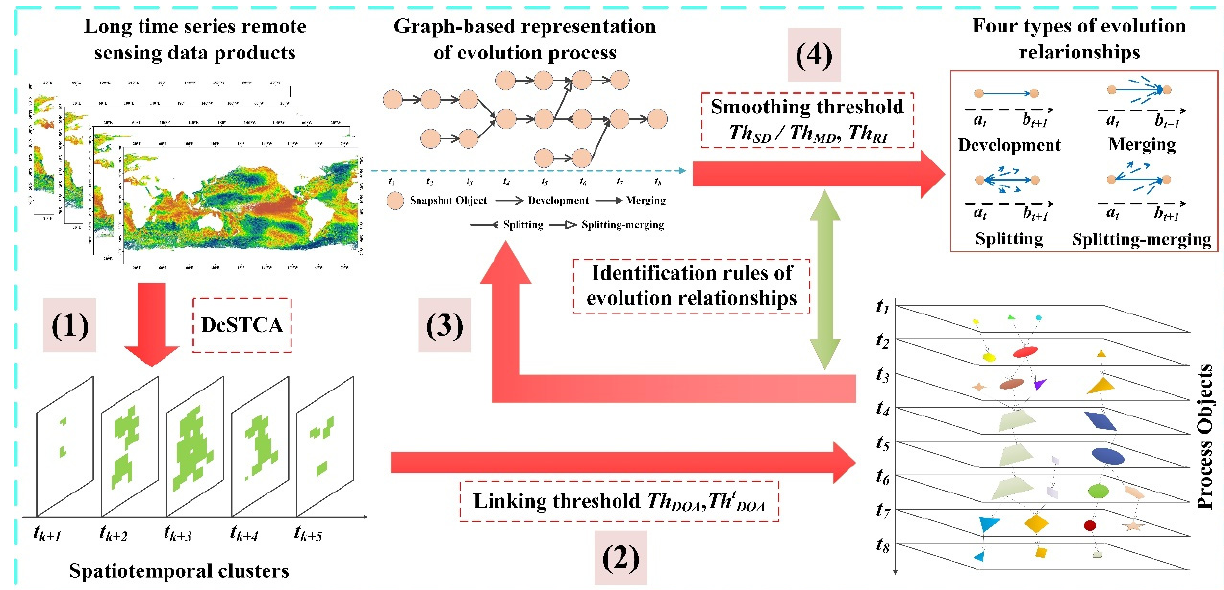
Figure 1. A workflow of PoAIES. ( 1 )–( 4 ) represent the four key steps of the PoAIES. The red arrow represents a processing step, the dashed box represents a method or a condition used in each step, and the green double-headed arrow represents a method or a condition used in different steps.